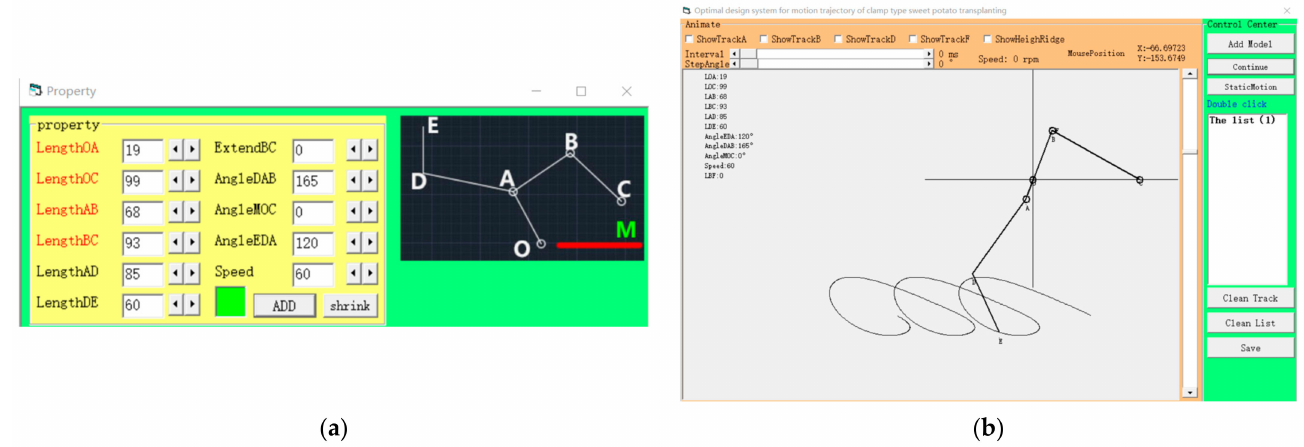
Figure 5. Optimizing system interface for transplanting manipulator. ( a ) Interface for adjusting parameters; ( b ) interface showing movement